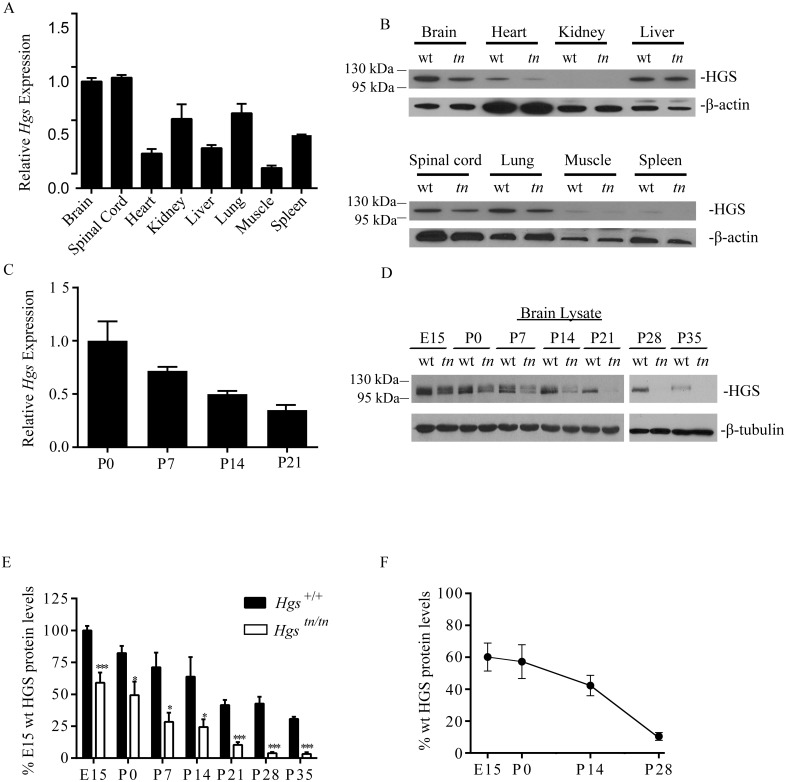
HGS expression in Hgs
+/+ and Hgs
tn/tn tissues.(A) qPCR analysis of Hgs mRNA expression in 4-week-old Hgs
+/+ tissues. Transcript level is expressed relative to Hgs level found in the brain. (B) Representative immunoblot of HGS expression in 4-week-old Hgs
+/+ (wt) and Hgs
tn/tn (tn) mice. β-actin was used as a loading control. (C) qPCR analysis of Hgs levels from the brains of Hgs
+/+ mice during postnatal development. (D) Representative immunoblot analysis of HGS expression from embryonic day 15 (E15) to postnatal day 35 (P35) in Hgs
+/+ (wt) and Hgs
tn/tn (tn) brain lysates. β-tubulin is used as a loading control. (E) Quantitation of developmental time course of HGS expression in Hgs
+/+ (wt) and Hgs
tn/tn (tn) mice expressed as percent of E15 Hgs
+/+ levels. Symbols represent unpaired t-tests corrected for multiple comparisons using the Holm-Sidak method. A one way anova with a Geisser-Greenhouse adjustment demonstrated a significant difference between time points. (F) Quantitation of HGS expression in Hgs
tn/tn mice expressed as a percent of Hgs
+/+ controls at each developmental time point. Data are shown as ± SE. Symbols represent unpaired t-tests. *p<0.05 and ***p<0.001.